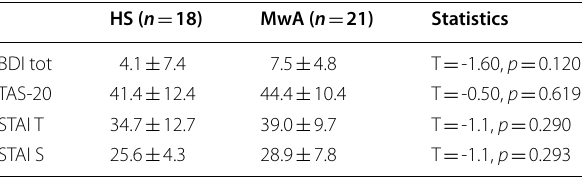
Table 2 Psychometric parameters of study’s participants. Inferential statistics based on Student’s t